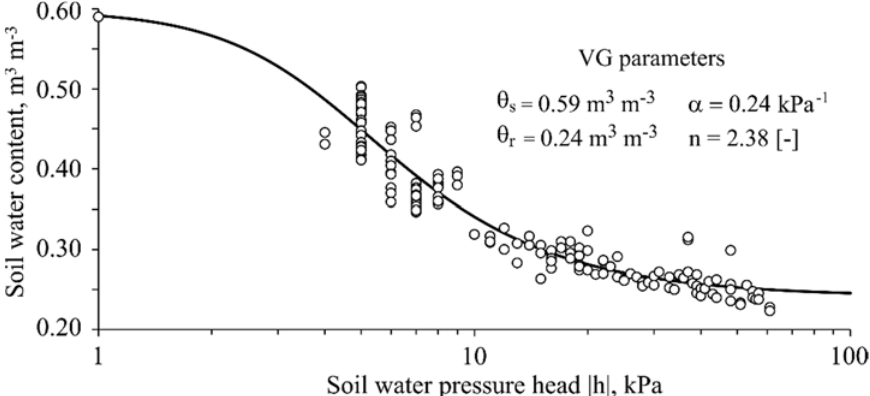
Figure 1. Soil water retention curve according to the Van Genuchten (VG) model [18] of the soil material after accommodation in the experimental units, together with its respective fitted parameters of Equation (1).